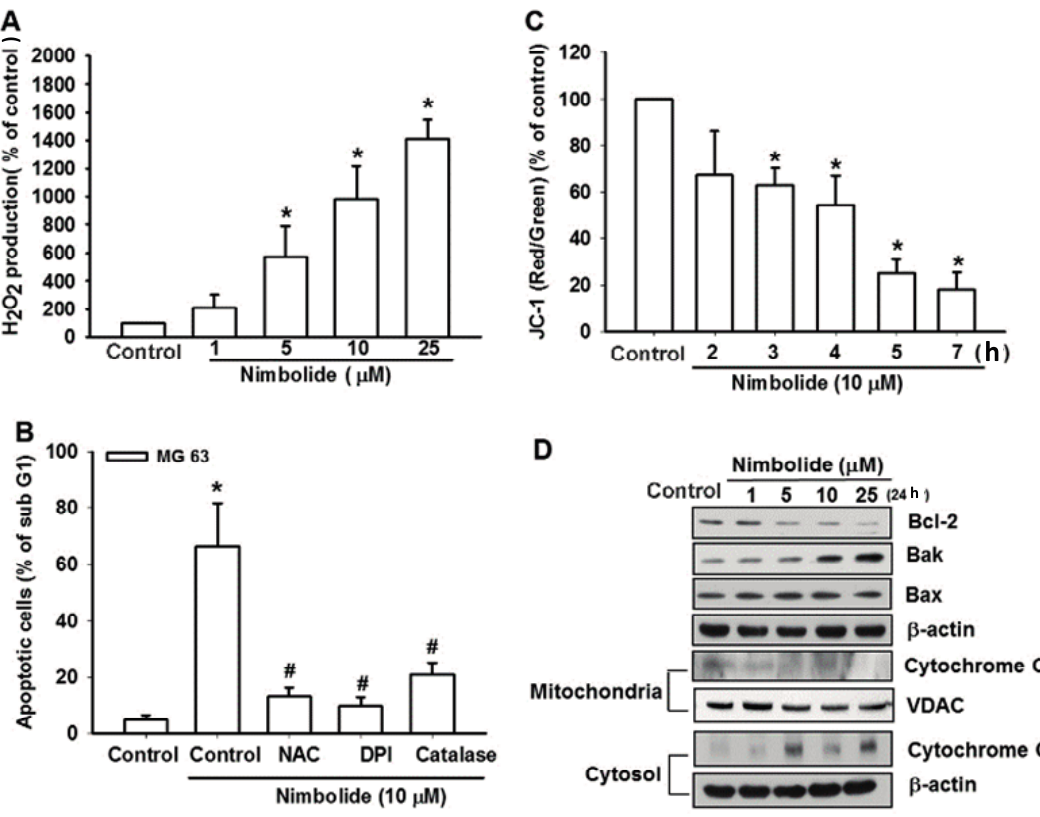
Figure 2. Nimbolide induces the generation of ROS and mitochondrial dysfunction in human osteosarcoma cells. ( A ) MG63 cells were treated with control solution or various concentrations of Nimbolide for 24 h. The concentration of H 2 O 2 as a measure of ROS production was examined by using flow cytometry; ( B ) MG63 cells were pretreated for 30 min with N -acetylcysteine (NAC), diphenyleneiodonium chloride (DPI), and catalase followed by treatment with Nimbolide (10 μ M) for 24 h. The percentage of apoptotic cells was then analyzed by flow cytometric analysis of PI-stained cells; ( C ) MG63 cells were treated as described in ( A ). The mitochondrial membrane potential was examined by using flow cytometry and JC-1 staining; ( D ) MG63 cells were treated with control solution or various concentrations of Nimbolide for 24 h. The expression levels of Bcl-2, Bak, Bax, mitochondrial cytochrome c, and cytosolic cytochrome c were examined by using western blot analysis; actin and voltage-dependent anion channels (VDAC) were used as internal controls. The data are expressed as the mean ± SEM. * p < 0.05 compared with controls. # p < 0.05 compared with the Nimbolide treated